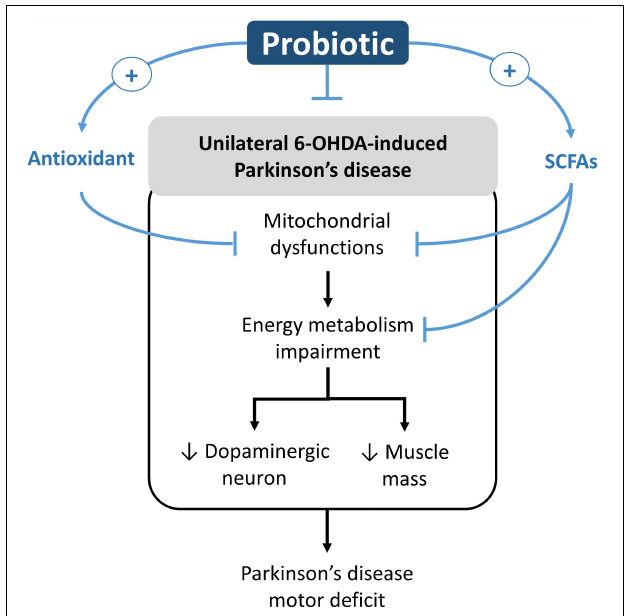
FIGURE 7 | Potential neurorestoration molecular pathway of probiotic in facilitating recovery of motor deficit in unilateral 6-OHDA-induced Parkinson’s